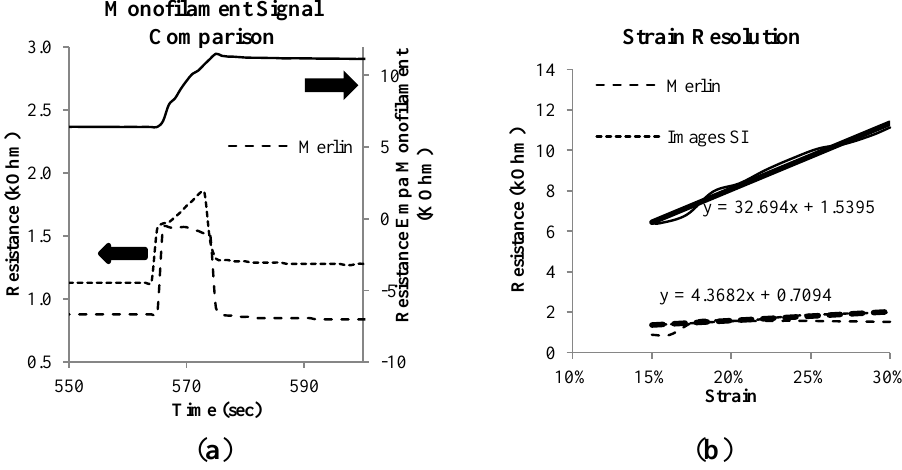
Figure 8. ( a ) Last strain step from 15%–30% of the cycle testing and ( b ) the corresponding resistance vs . strain plot with slopes calculated for the Images SI and Empa monofilaments.